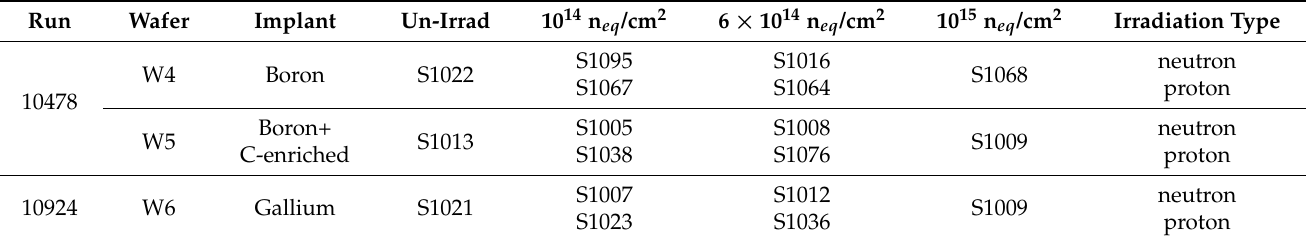
Table 1. List of tested CNM devices with different implants (boron, boron plus carbon and gallium) irradiated up to 10 15 n eq /cm 2